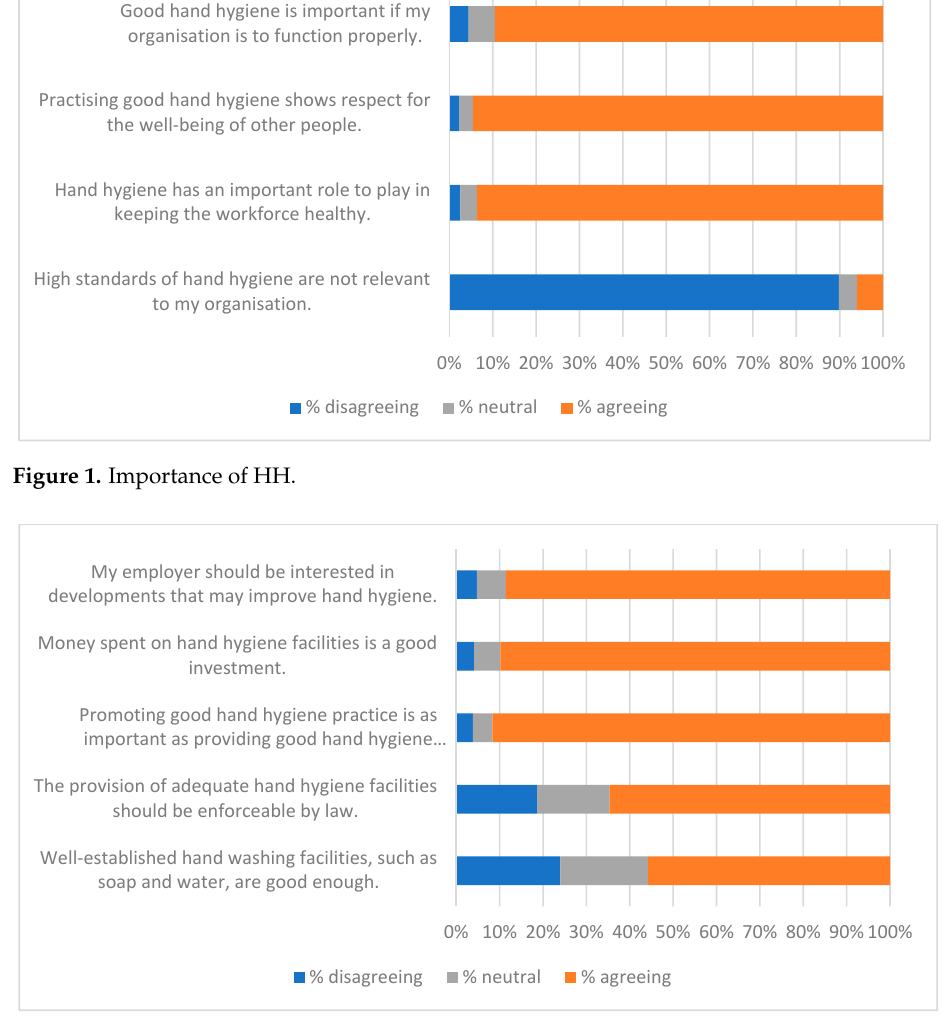
Figure 2. Investing in HH.